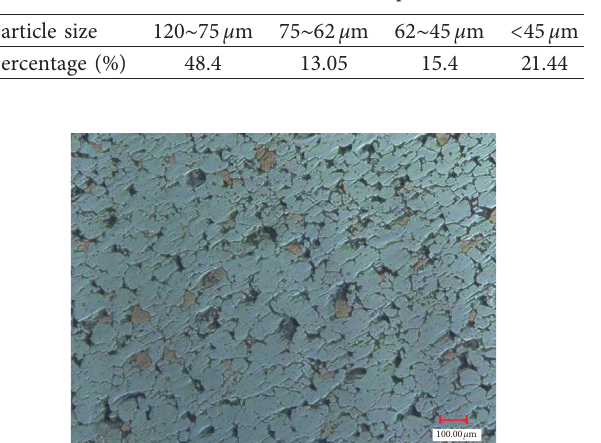
Table 2: Size distribution of the particles.